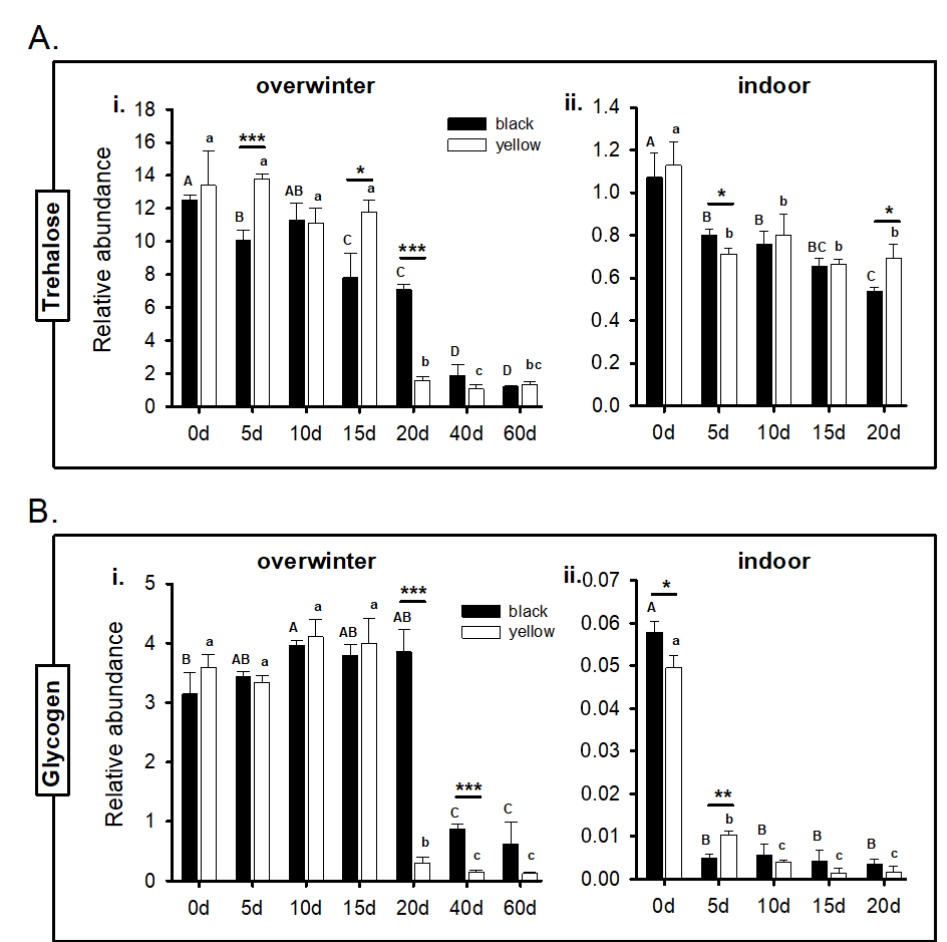
The content of trehalose decreased significantly at 5 days, followed by a slight increase at 10 days and a subsequent significant decrease from 10 to 60 days in the overwinter black population; thus, the trehalose content was highest at day 0 and lowest at day 60 of cold storage (Figure 2(Ai)). The content of trehalose in the yellow population did not significantly change during the first 15 days of cold-stress storage and then decreased significantly, with no further changes from day 20 to day 60; the highest level was at day 0 and the lowest level was at day 40. The content of trehalose in yellow adults was higher than that of black adults at 5 days and 15 days, whereas this trend shifted at 20 and 40 days for the overwinter population (Figure 2(Ai)). The content of glycogen showed an increasing trend from 0 to 20 days, with a relatively lower level at 40 and 60 days in the black population; the highest level was detected at 10 days and the lowest level was detected at 60 days (Figure 2(Bi)). The content of glycogen in the yellow population did not significantly change during the first 15 days of cold-stress storage, although it increased from 5 to 15 days and then decreased significantly from 20 to 40 days; the lowest level was detected at day 60 and the highest level was detected at day 10 (Figure 2(Bi)).